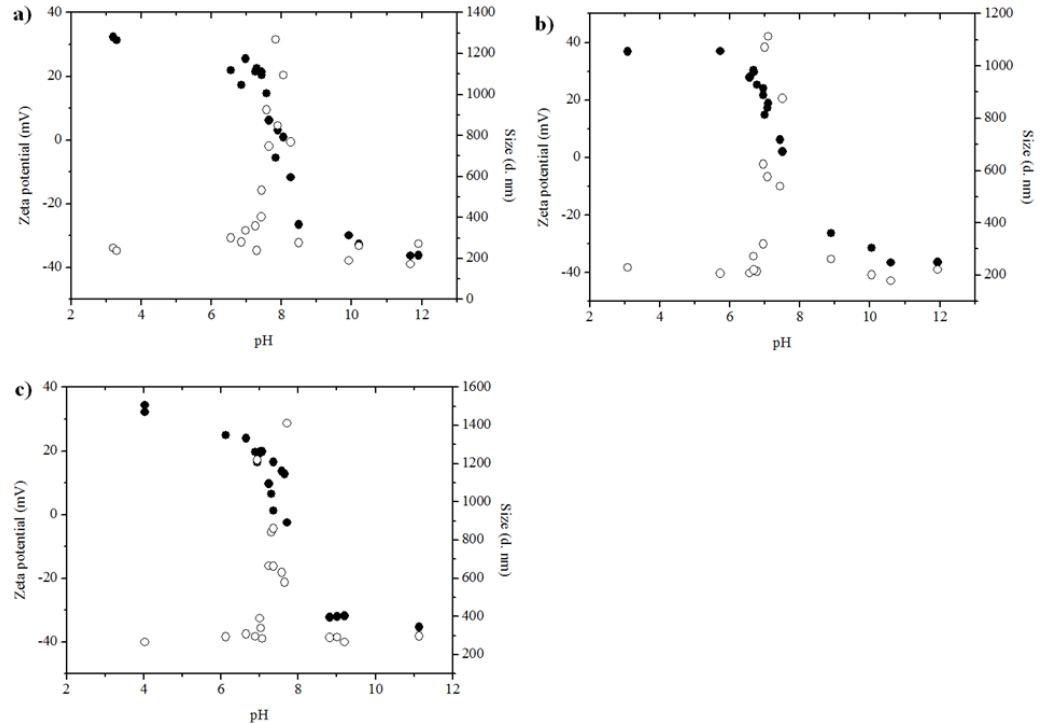
Figure 3. Z-average (Z ave ) hydrodynamic diameter ( ○ ) and ζ potential (●) of: ( a ) 5 nm; ( b ) 10 nm; and ( c ) 20–30 nm γ-Al 2 O 3 NP aggregates, as a function of pH.